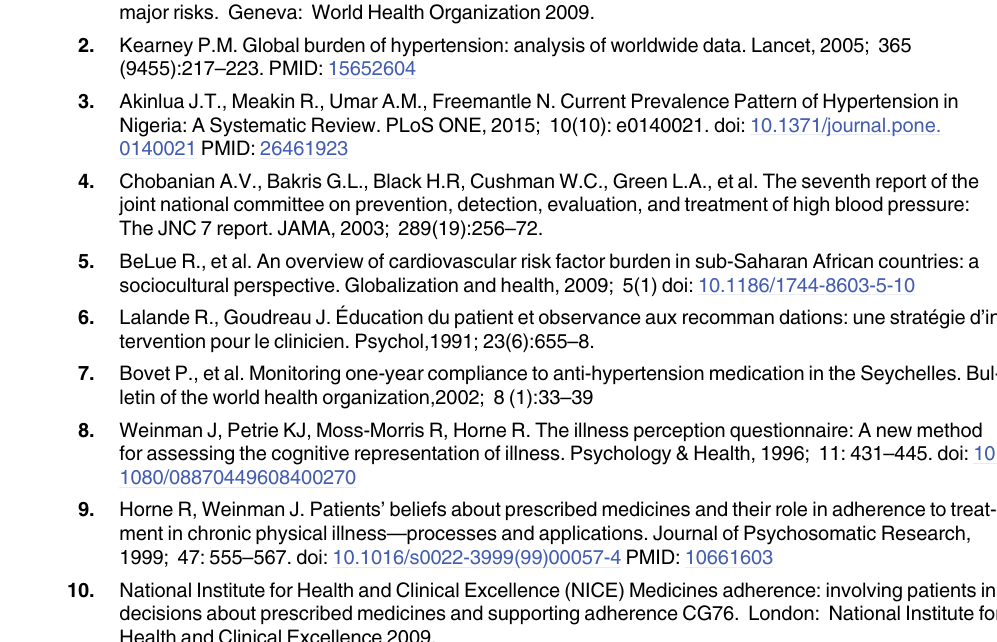
S8 Table. Quality appraisal of quantitative studies. S9 Table. Examples of beliefs statements on hypertension per EM among qualitative stud-